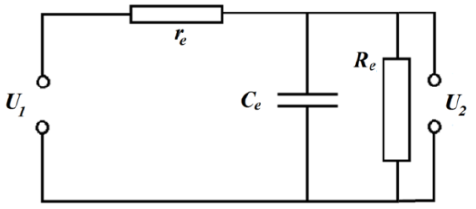
Figure 4. Electrical circuit of the HB: r e — electrical resistance of the wires, R e — electrical resistance of ER fluid, C e — electric capacity of the HB, U 1 — power supply voltage, U 2 — voltage on the blades.